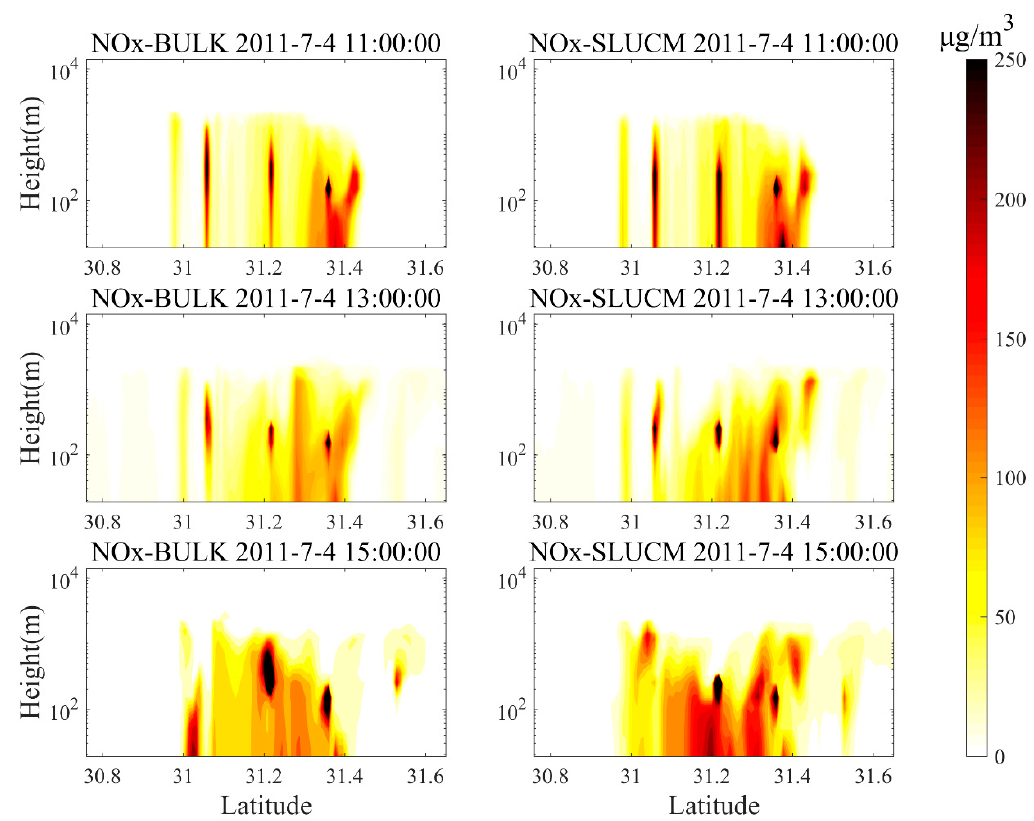
Figure 13. Vertical distribution of simulated NO x concentrations along the longitude 121.4° E during the process of the cold front passing.